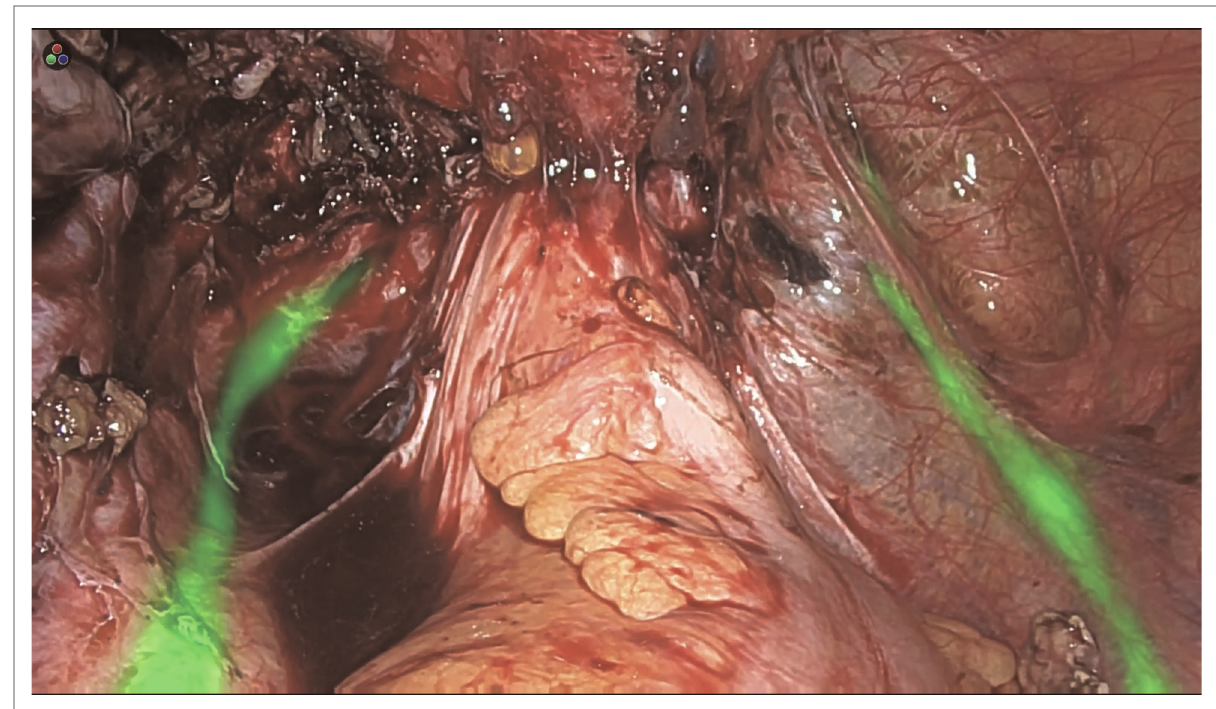
FIGURE 1 ICG visualization of the ureters during DE laparoscopic